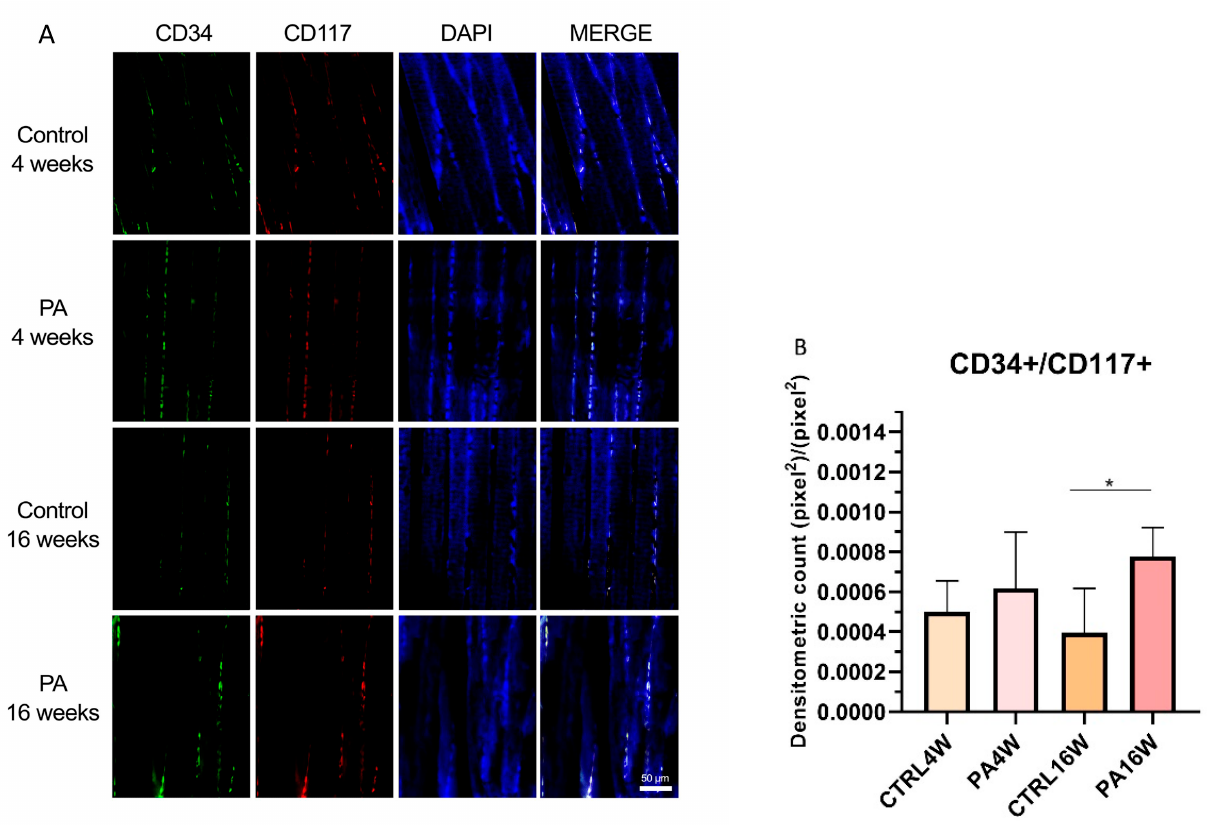
Figure 5. ( A ) Representative images of double immunofluorescence staining for muscle tissue TCs as determined by CD34+/CD117+. CD34 (green) and CD117 (red) immunostaining with 4 (cid:48) ,6-diamidino-2-phenylindole (DAPI; blue) coun- terstain for nuclei. ( B ) Comparison between PA16W and CTRL16W highlights a significant higher expression of TCs in exercised rats at 16 weeks ( * p < 0.05). No other comparisons show to be significant. Data were tested for normality with the Kolmogorov–Smirnov and Shapiro–Wilk test, and differences between experimental groups were evaluated by using one-way ANOVA, followed by Tukey’s multiple comparison post hoc test. The slides are scanned by confocal laser